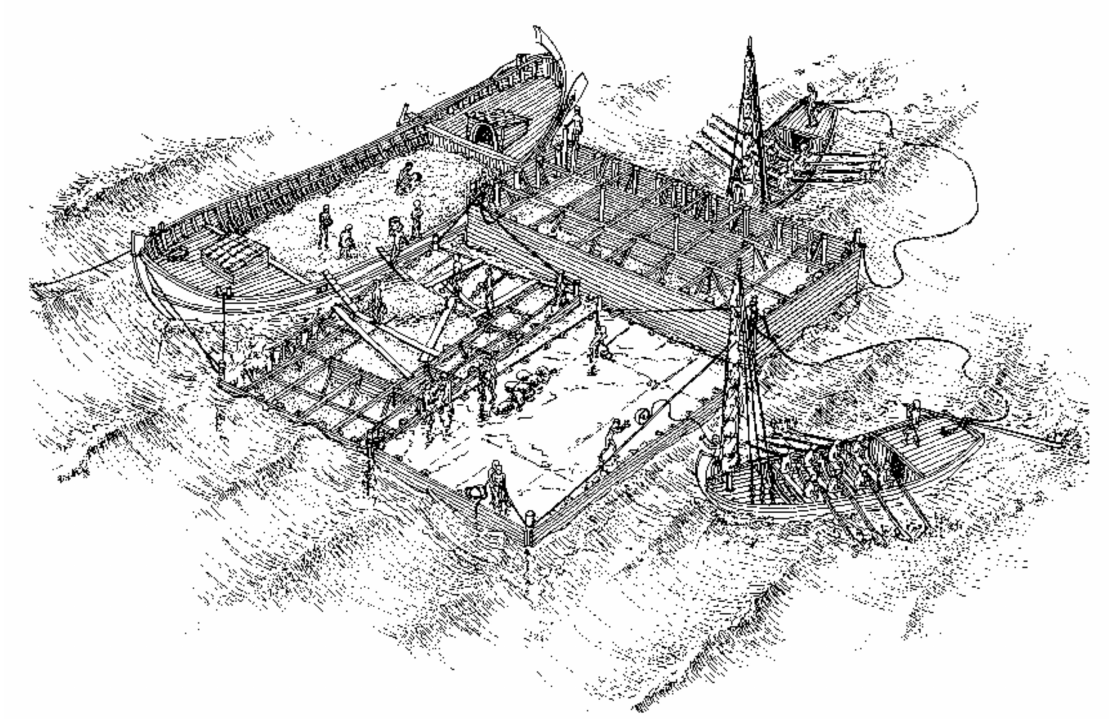
Figure 1. Reconstruction of prefabricated caissons being positioned and loaded with concrete at Area K at the northern end of the main enclosing mole at Caesarea [4] (p. 213). Drawing: C.J. Brandon; used with kind